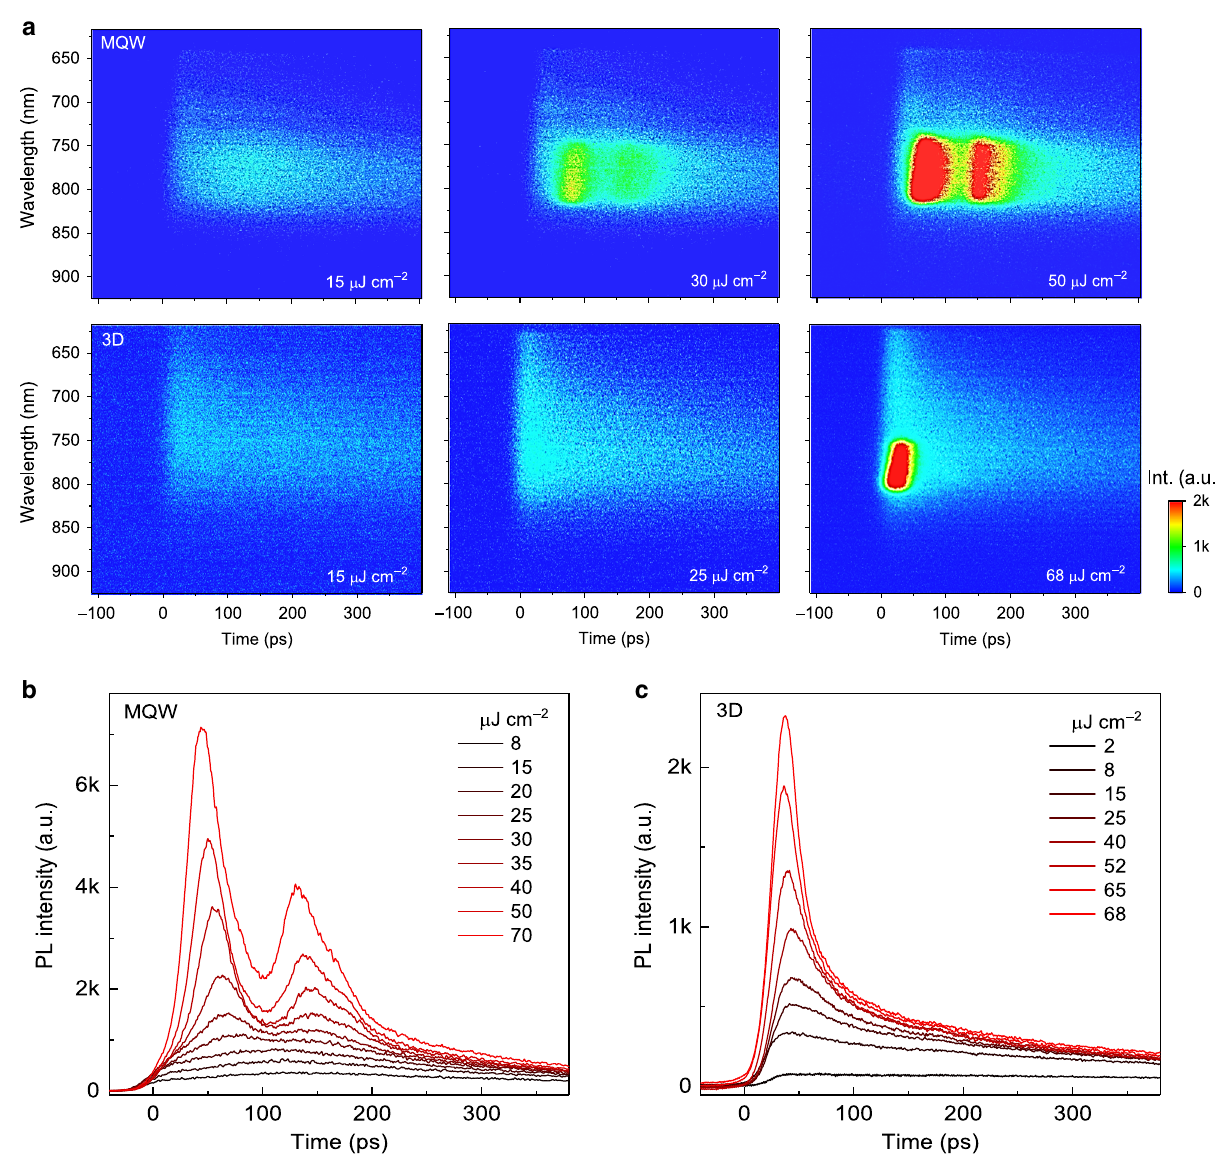
Fig. 2 Ultrashort laser pulse doubling by perovskite multiple quantum wells (MQWs). a Pseudocolor time-resolved photoluminescence (TRPL) images show the spectrum evolution with time of the MQWs (upper panel) and 3D (lower panel) perovskite fi lms at three representative pump fl uences, respectively. b and c The extracted TRPL decay curves of b perovskite MQWs at the position of 780 ± 20 nm and c 3D perovskite at the position of 790 ± 20 nm under different pump fl uences. These results were collected from samples excited with 400-nm laser pulses (1 kHz, 50 (Fig. 1c and d). The slope of the power-dependent output PL intensity increases from 0.5 below the threshold to around 3 above the threshold and fi nally approaches around 1 at high pump fl u- ence, corresponding to the transitions from spontaneous emission to ampli fi cation by StE and ultimately to gain saturation 26,27 . These features clearly indicate that the HD QWs serve as the optical gain medium. In comparison, the threshold of StE from the control sample, 3D FAPbI 3 perovskite fi lm, is around 45 μ J cm − 2 under the same excitation conditions (Supplementary Fig. 2).